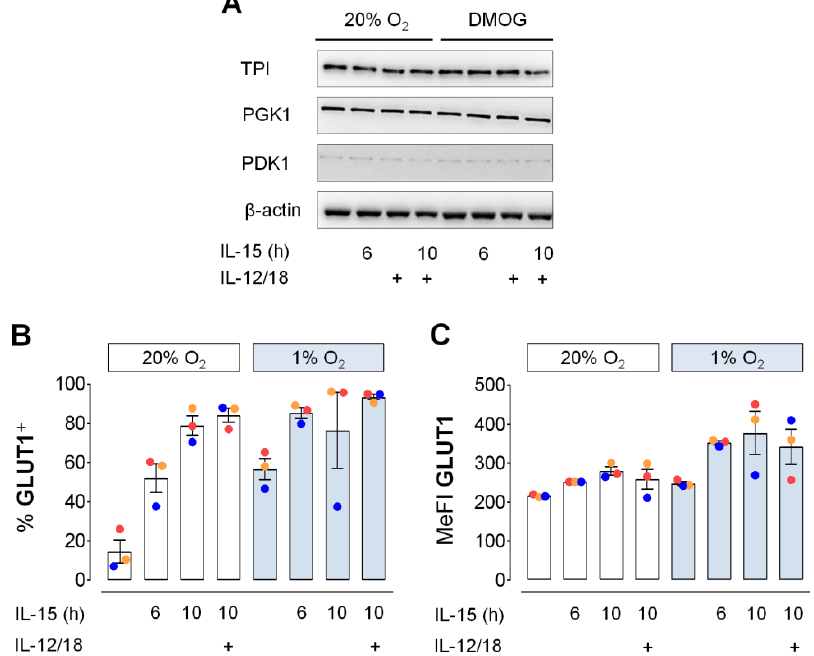
Figure 4. Glycolytic protein expression in primed human NK cells. ( A ) NK cells from buffy coats were cultured under normoxia (20% O 2 ) or chemical hypoxia (DMOG). IL-15 was added at 16 h followed by IL-12 and IL-18 (IL-12 / 18) at 22 h. Cells were collected at 26 h and analyzed by anti-TPI, -PGK1 and -PDK1 immunoblotting using anti- β -actin as loading control. One representative experiment of 3 performed is shown. ( B , C ) IL-15 was added to NK cell cultured under normoxia (20% O 2 ) or hypoxia (1% O 2 ) at 16 h and IL-12 / 18 at 22 h. Cells were collected at either 22 h (6 h IL-15 only) or at 26 h (untreated controls and 10 h IL-15 with or without 4 h IL-12 / 18) . Flow cytometric data for ( B ) the proportion of GLUT1 + NK cells and ( C ) GLUT1 MeFI is represented as mean values ± SEM (bars)